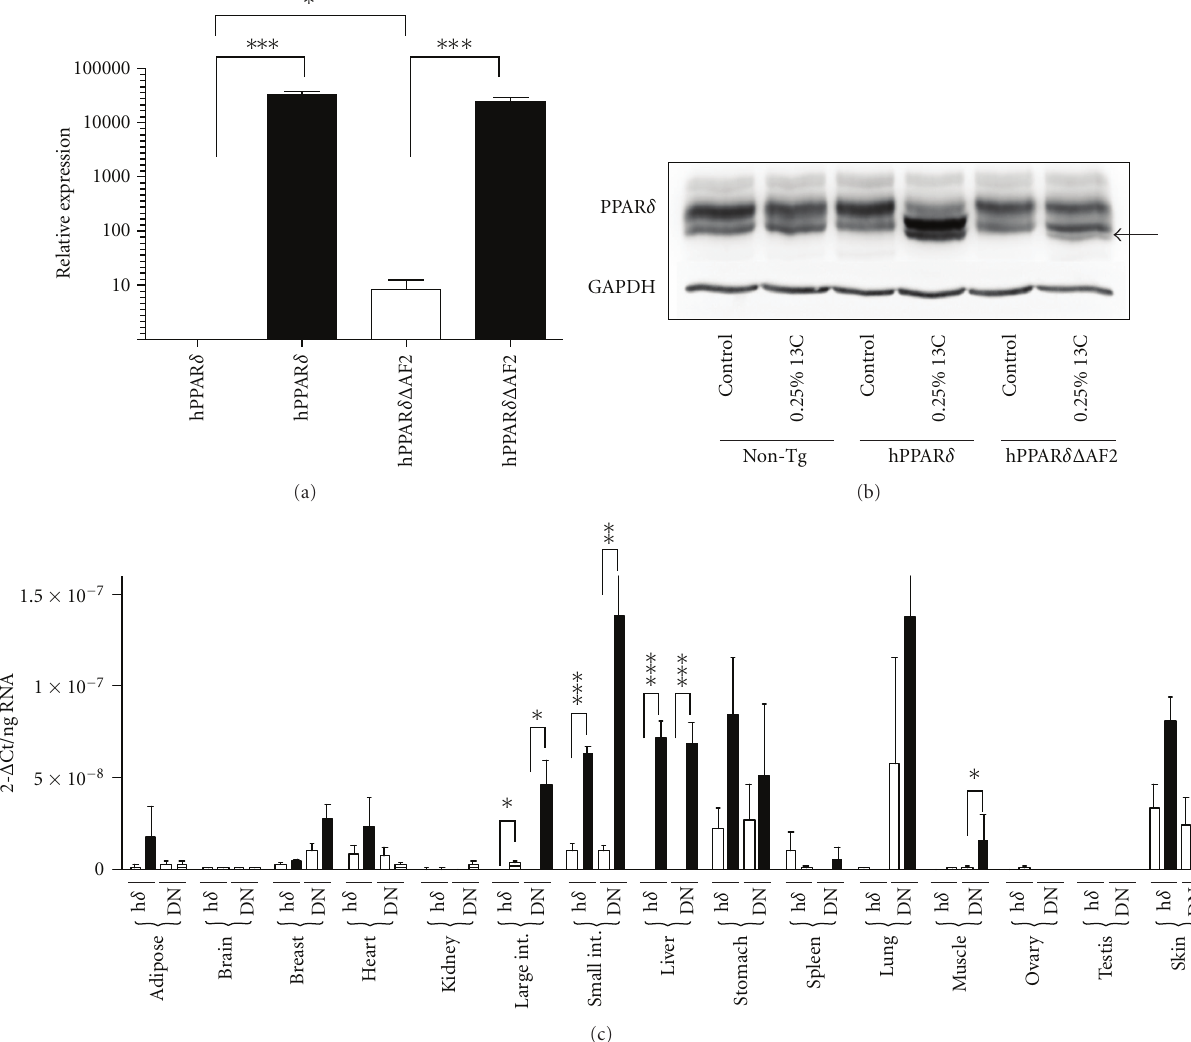
Figure 2: Mice conditionally express hPPAR δ or hPPAR δ Δ AF2 transgenes in response to feeding I3C. Animals ( n = 3 per group, 10 weeks old, mixed male and female) were placed either on control diet or a diet containing I3C (0.25% (w/w)) for 5 days. (a) hPPAR δ and hPPAR δ Δ AF2 exhibit low basal mRNA expression (open bars) and highly inducible I3C-dependent expression (black bars) in mouse liver. (b) hPPAR δ and hPPAR δ Δ AF2 protein is expressed in livers in response to dietary supplementation with I3C. (c) hPPAR δ (h δ ) and hPPAR δ Δ AF2 (DN) mRNA expression in various mouse organs in response to normal diet (open bars) and I3C-supplemented diet (black bars). Statistical significance where indicated was analysed using Mann-Whitney nonparametric test in GraphPad Prism version 5.0c, (GraphPad Software, San Diego, CA, USA). Significance is portrayed as ( ∗ P ≤ 0 . 05; ∗∗ P ≤ 0 . 01; ∗∗∗ P ≤ 0 .